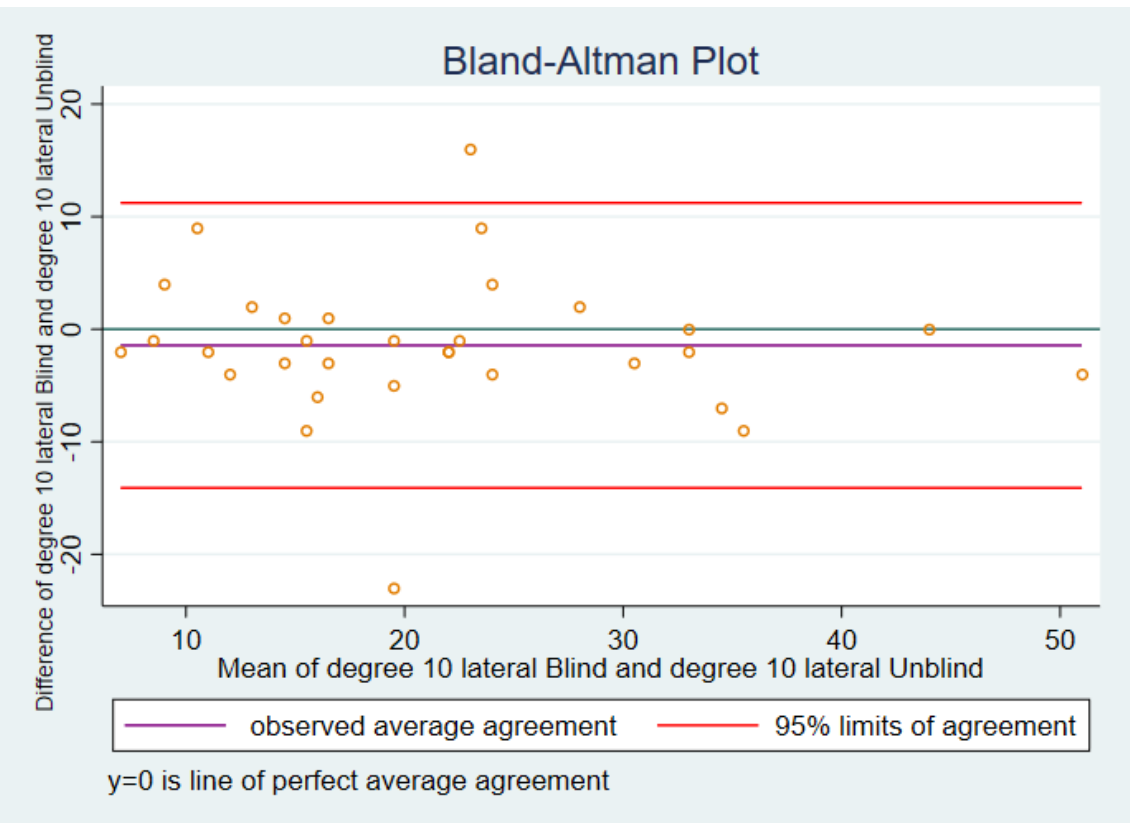
Figure 3. Ten degrees, lateral.